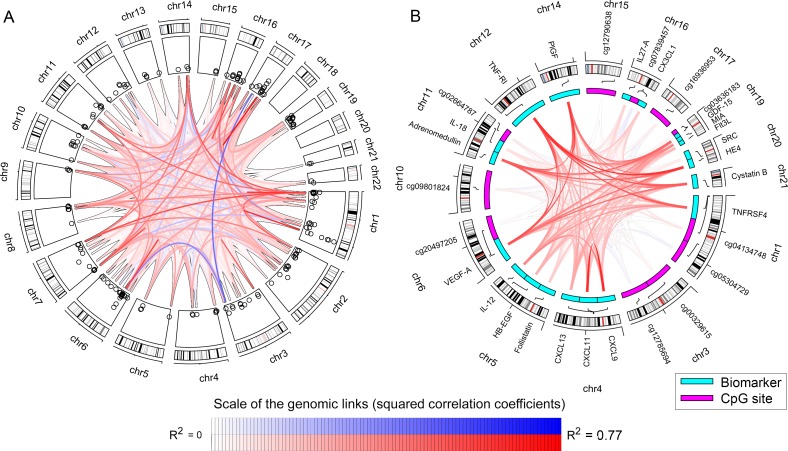
Correlation links between genomic regions.The links between the CpG sites represent squared correlation coefficients (R2) ranging from zero to 0.77 reflected by the intensity in the color with red representing positive correlations and blue negative correlation. A) Shows the correlation pattern between DNA methylation levels at different CpG sites across the autosomal chromosomes. Only CpG sites associated with any of the biomarkers are included. The outer circle shows the chromosome number, second circle shows the cytobands for each chromosome clock wisely directed. The third circle is an extract from the Manhattan plot the–log10(P-values), with the scale ranging from 7 to 24. B) Shows the correlation pattern between CpG sites that are associated with multiple biomarkers and the correlation pattern between these biomarkers. The second circle is the names of the CpG sites and the biomarkers included in theses analyses. Inside the cytoband-circle, the CpG cites (magenta) and the genes encoding respective biomarker (cyan) with lines to the genomic position are shown.